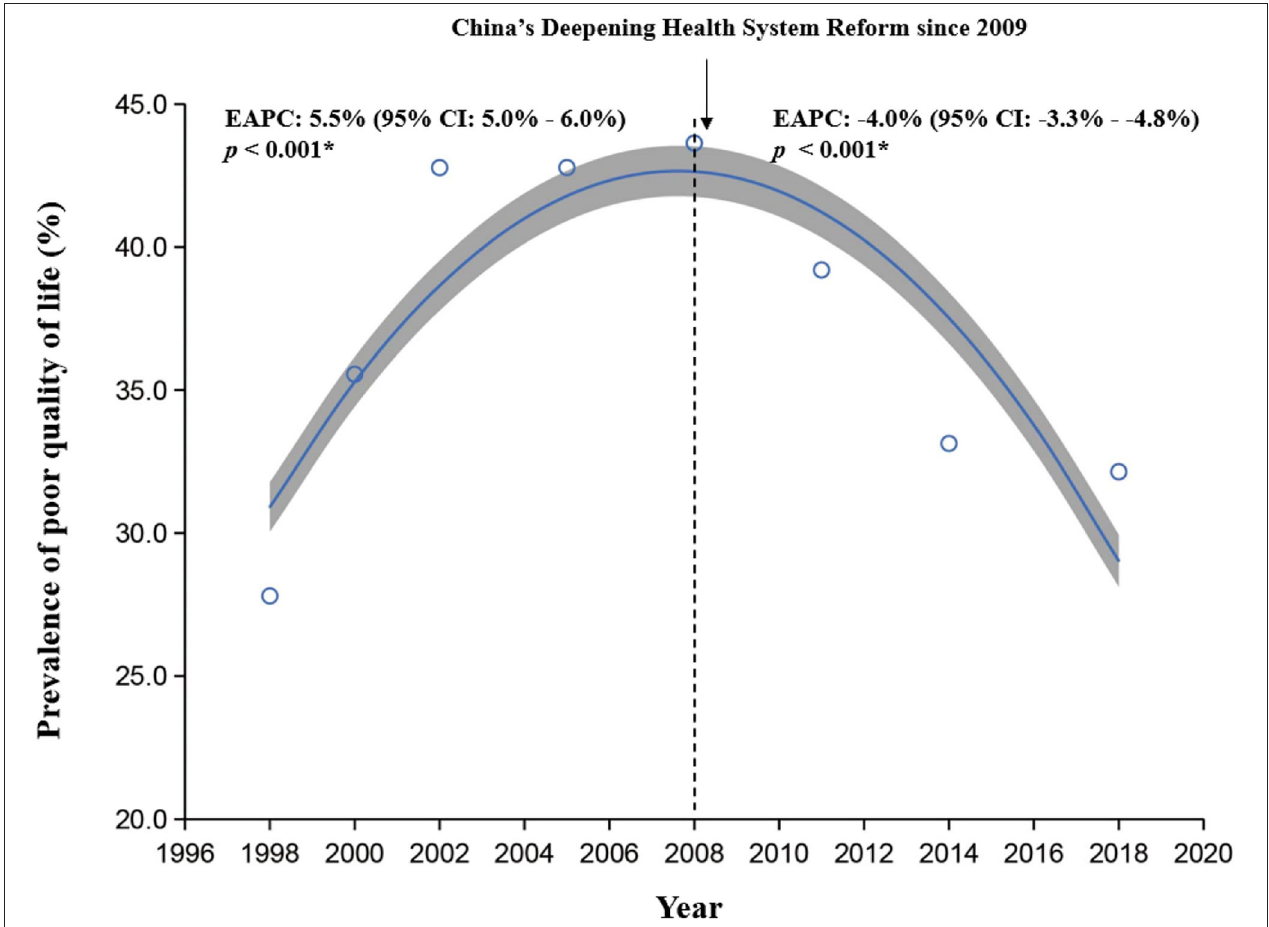
FIGURE 2 | The trends in the prevalence of poor quality of life from 1998 to 2018 by locally weighted scatterplot smoothing regression analysis. EAPC, estimated averaged percentage